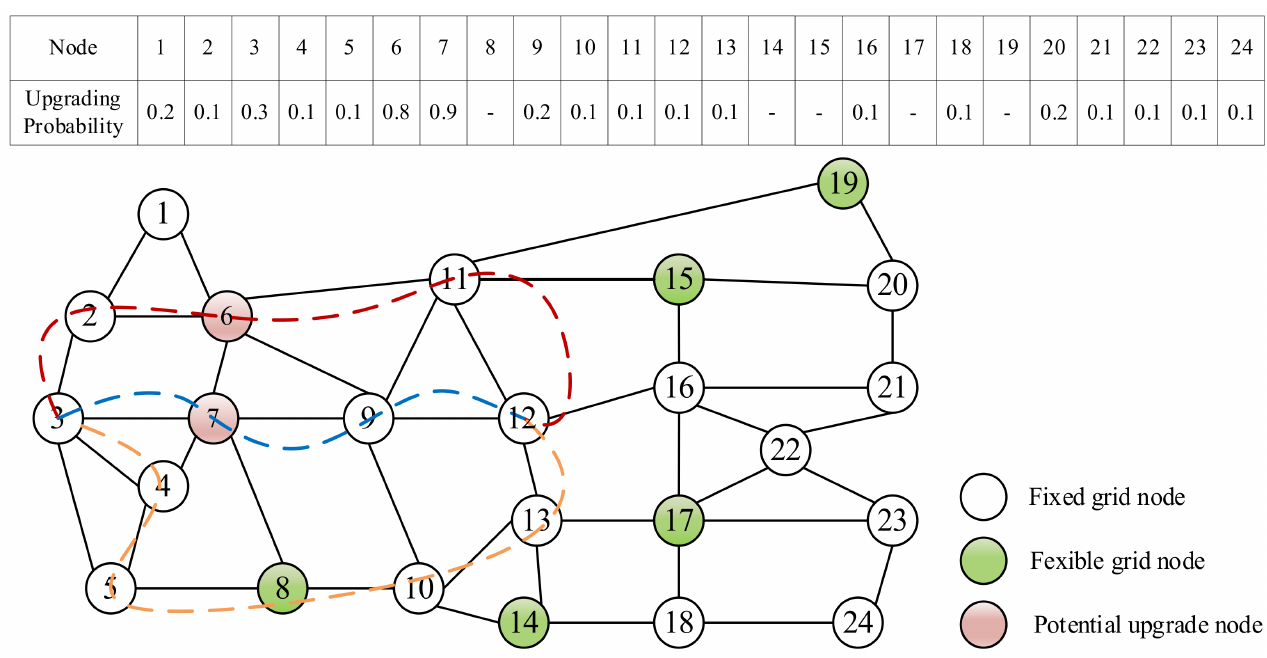
Figure 2. Migration scenario with traffic survivability issue when two nodes will be selected to be upgraded to